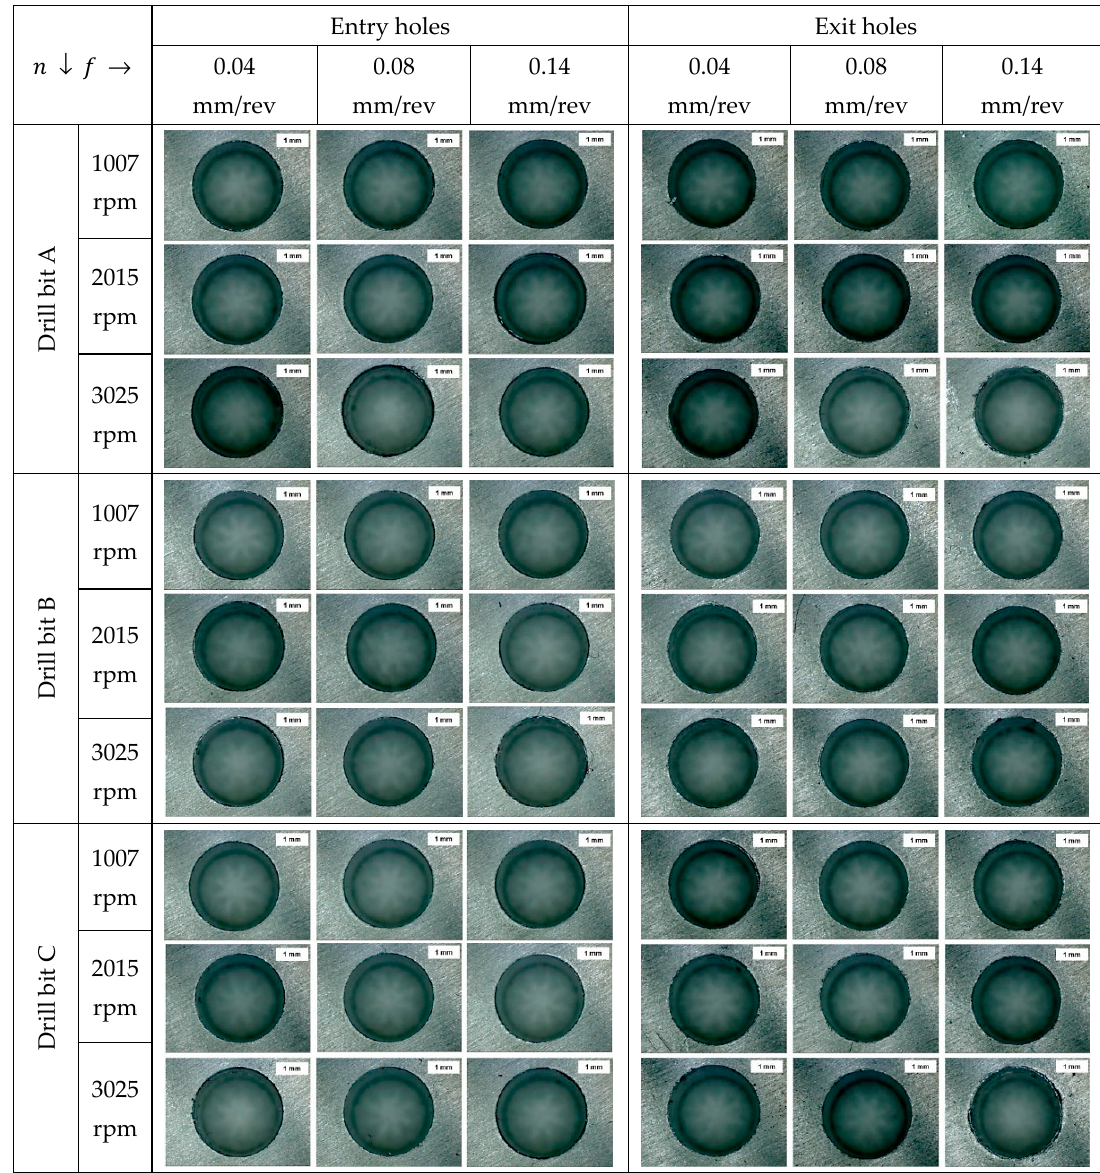
Figure 5. Hole images from TiCN coated carbide drills.